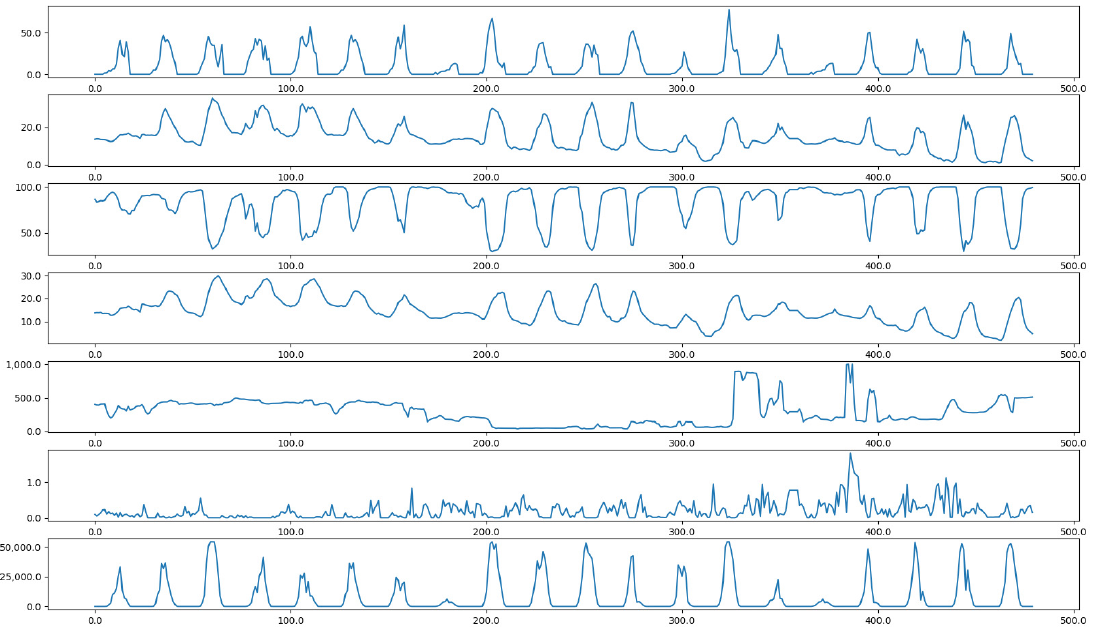
Figure 6. Shape of seven time series corresponding to output and inputs.